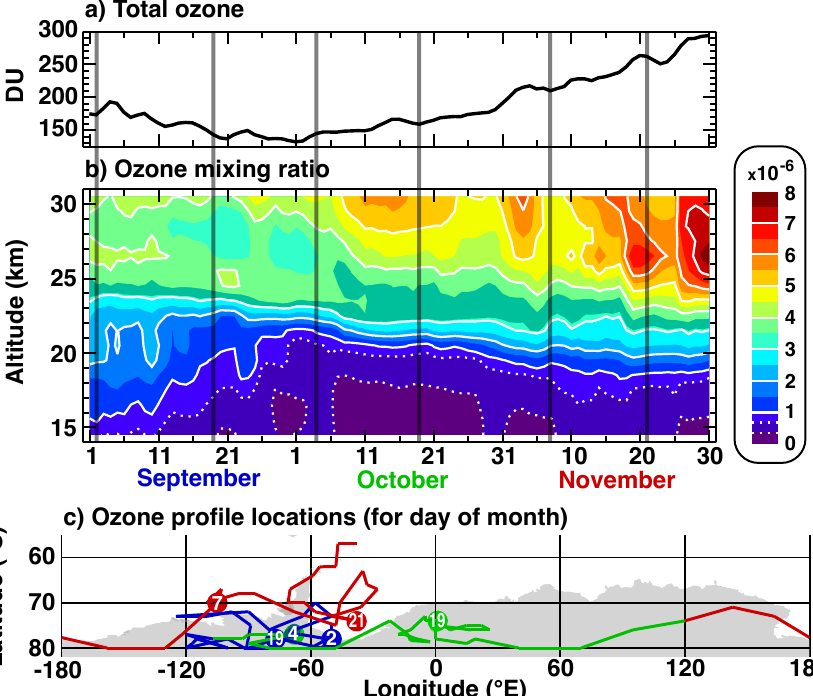
Fig. 6. (a) OMPS TC-NM total ozone and (b) OMPS LP ozone mixing ratios (14.5–30.5km) for the 1 September–30 November 2012 period, derived from (c) a location chosen near the center of the polar vortex. In (c) the chosen locations are connected by colored lines: September (blue), October (green), and November (red). Vertical gray lines in (a) and (b) and circles in (c) indicate the days 2 September, 19 September, 4 October, 19 October, 7 November, and 21 November. The OMPS LP daily data have been smoothed in time by a 1-2-1 filter. The Antarctic continent is shaded in gray in (c) (adapted from Newman et al., 2013, Fig. 6.10).